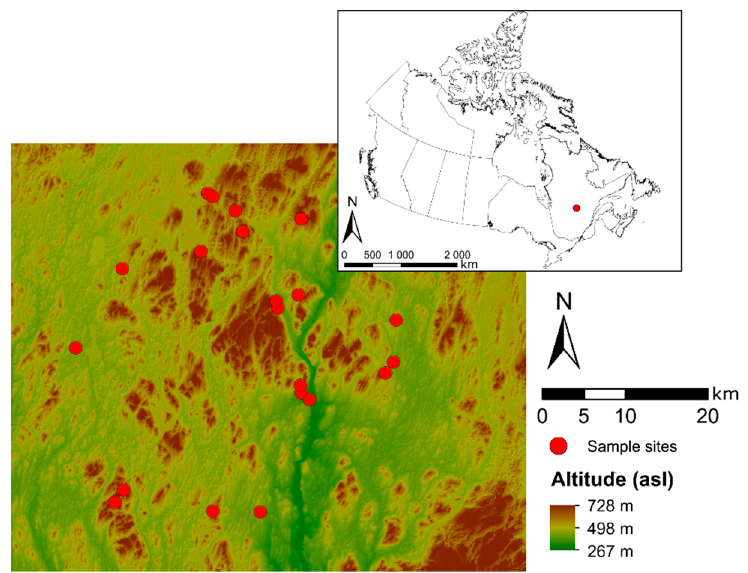
Figure 1. Location of the sampled sites in the study territory. The insert map indicates the localization of the study territory in Canada. The topographic raster came from the data of the Shuttle Radar Topography Mission [69]